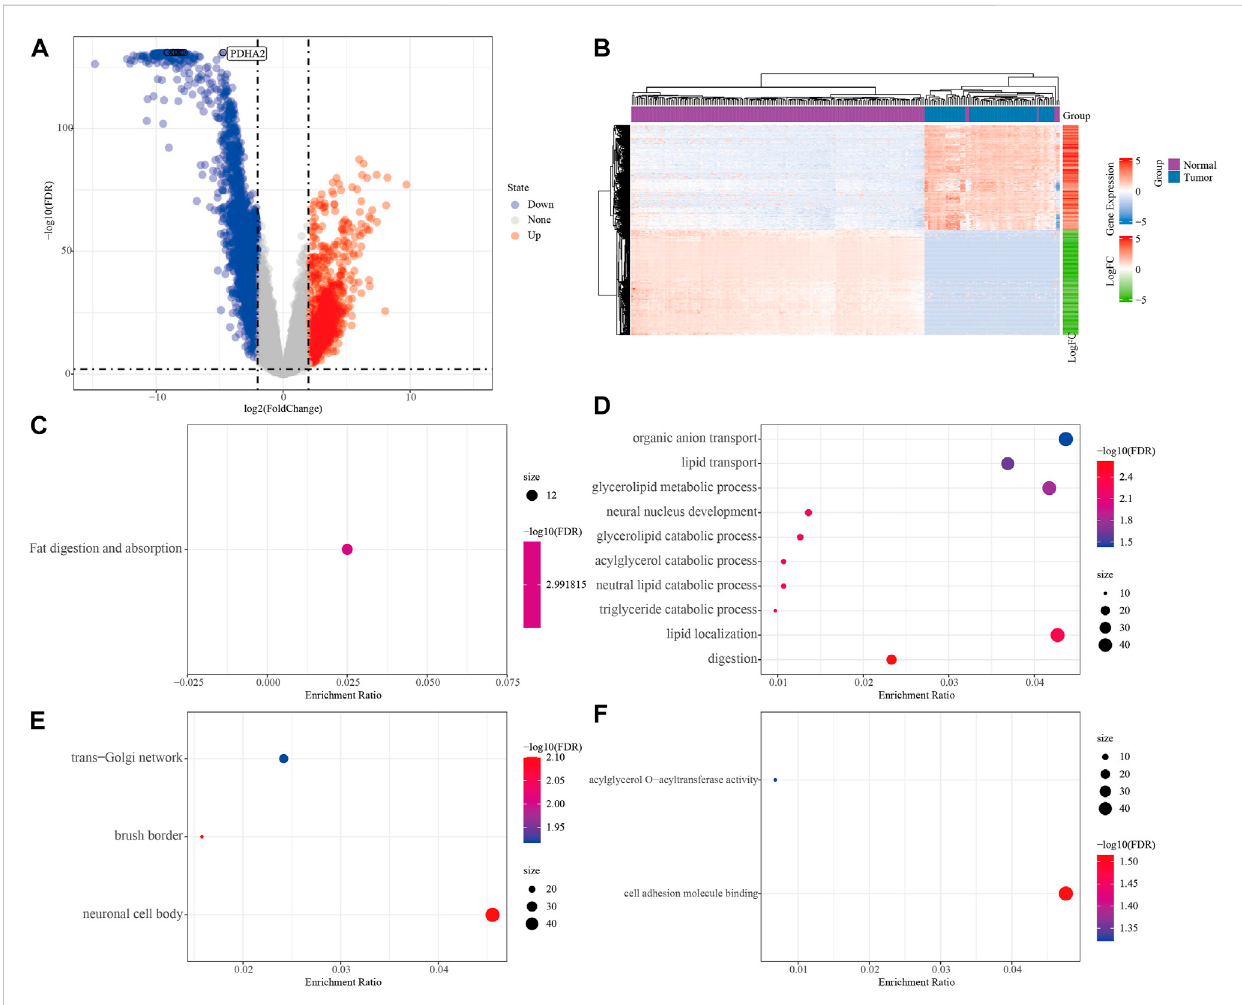
FIGURE 2 Analysis of PAAD differential genes. (A) Volcano plot of differentially expressed genes in expression pro fi le. (B) Heat map of differentially expressed genes. (C) Results of differential gene KEGG enrichment. (D) Results of differential gene GO BP enrichment. (E) Differential gene GO CC enrichment results. (F) Differential gene GO MF enrichment results, the color from blue to red in CDEF represents FDR from large to small, the size of the dot represents the number of enriched to genes, a larger dot indicates more enriched